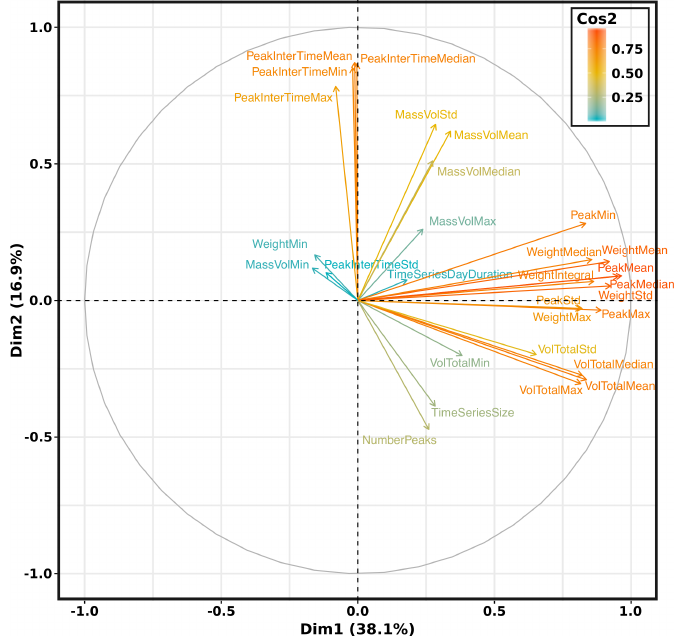
Figure 15. Correlation graph.